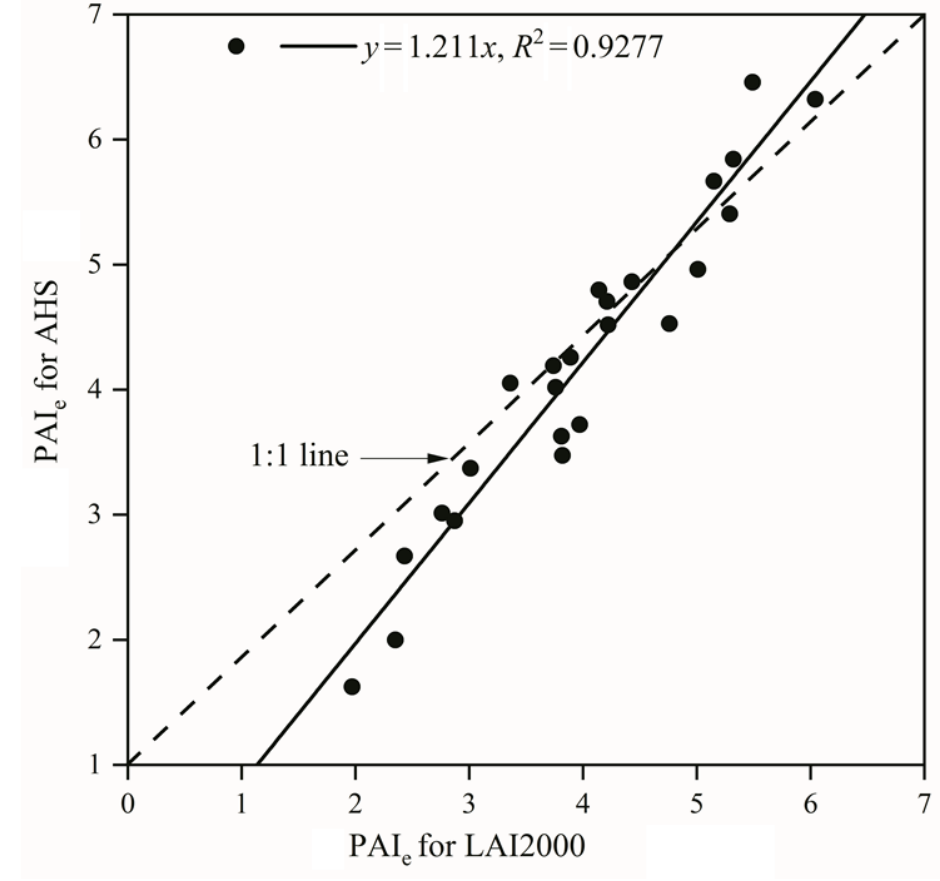
Figure 6. Comparison of the results from the LAI-2200 and the AHS.